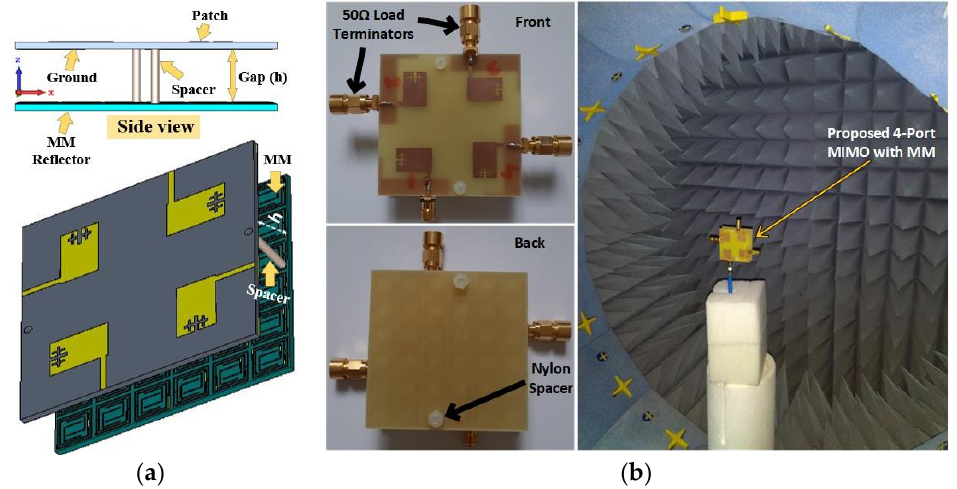
Figure 7. ( a ) Simulation arrangement and side view of the designed MIMO system with MM reflector and ( b ) snapshots of the developed MIMO prototype with MM (front and back) and SATIMO measurement system.